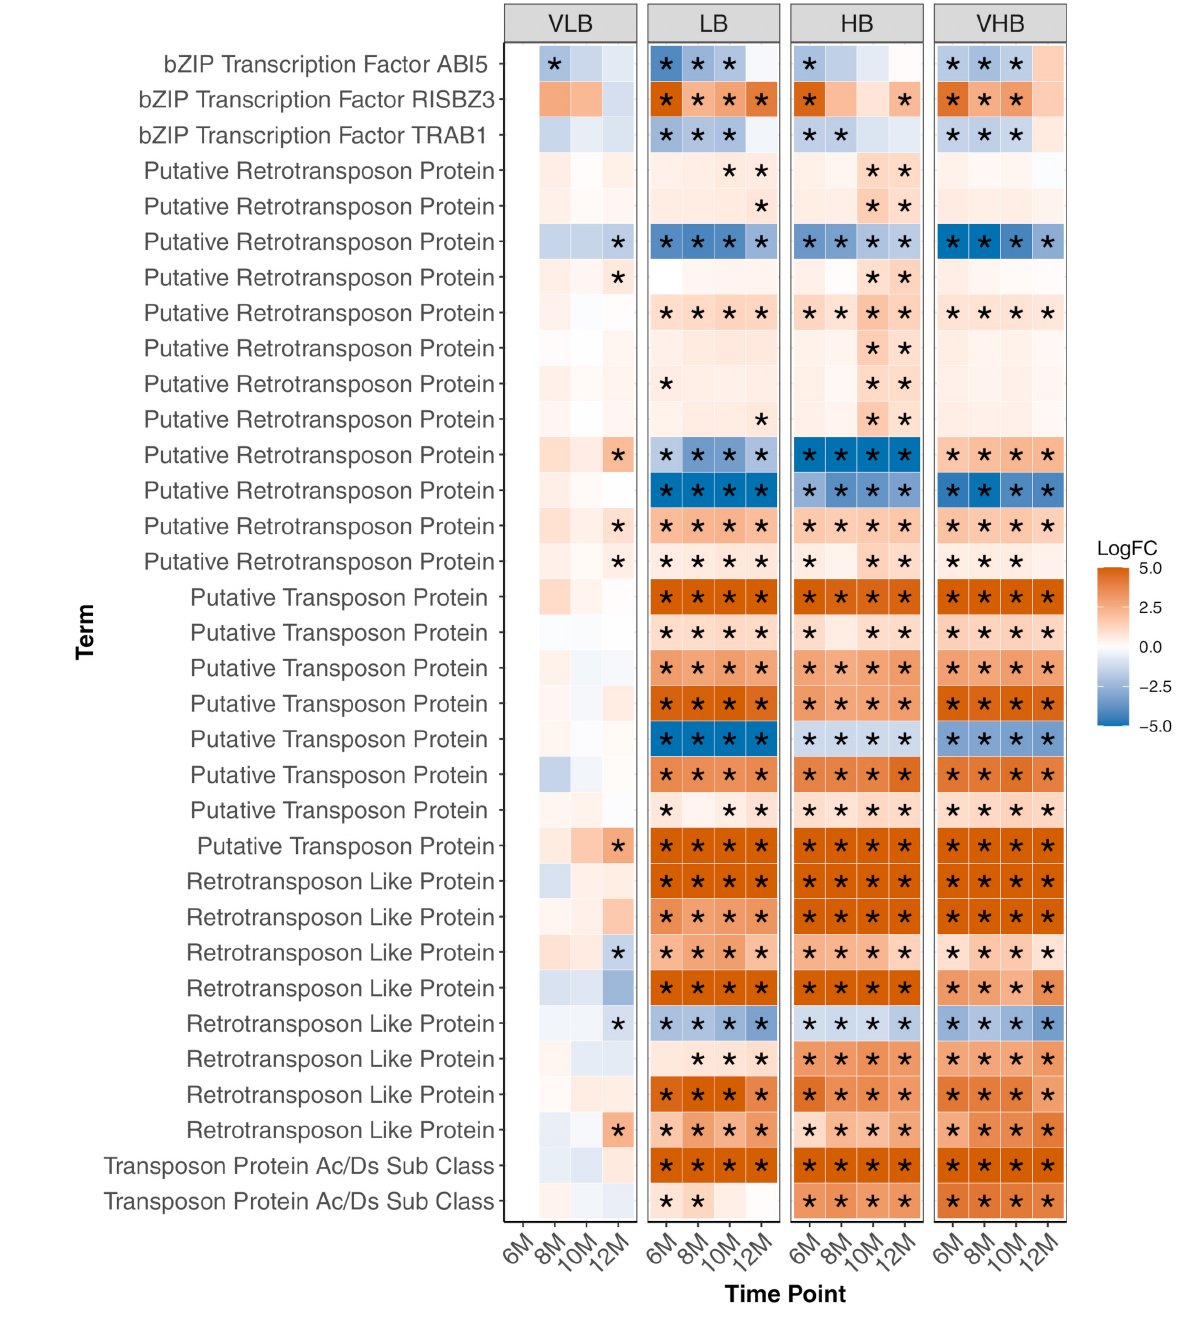
FIGURE 5 | Expression profiles of genes involved in response to stress. Asterisks indicate genes with differential expression for a particular combination of genotype and time point. The age of plants in the x axis is shown in months. VLB: very low ◦ Brix, LB: low ◦ Brix, HB: high ◦ Brix and VHB: very high ◦ Brix. All tests considered 6-month-old VLB as a reference